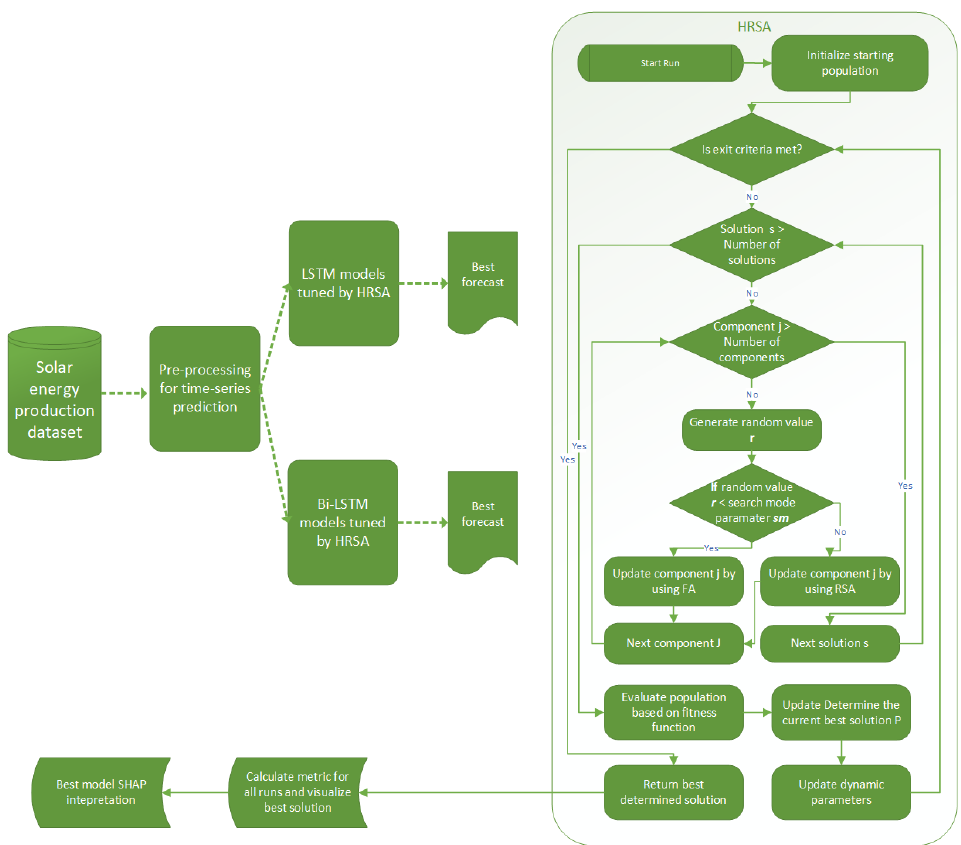
Figure 2. Flowchart of the proposed